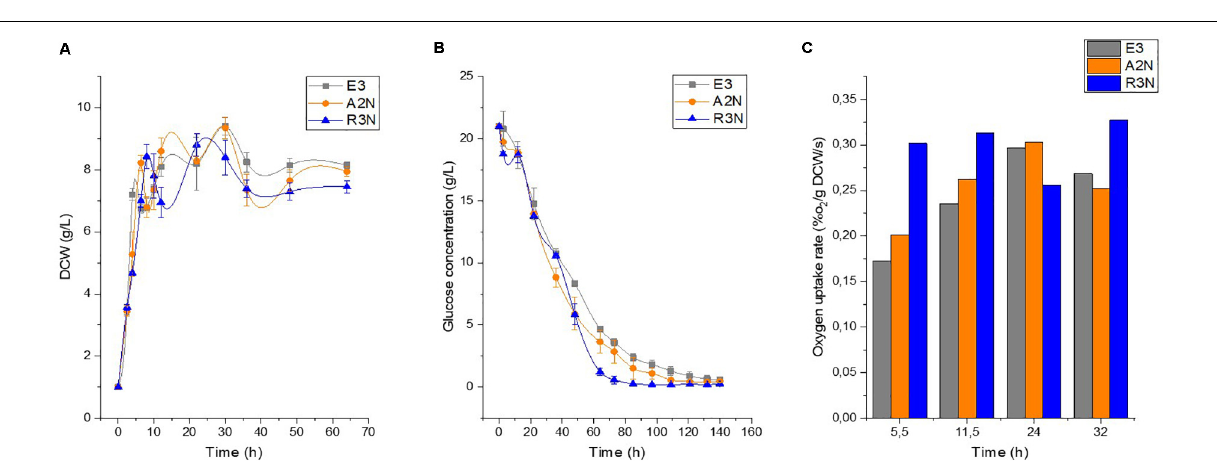
FIGURE 3 | Physiological comparison between E3 and the NOX-expression strains regarding the growth, namely dry cell weight (DCW) (A) , the glucose consumption (B) , and the oxygen uptake rate (C) . Data are shown as mean ± standard deviation from at least three independent experiments for measuring growth and glucose concentration. Oxygen utilization was obtained from duplicate